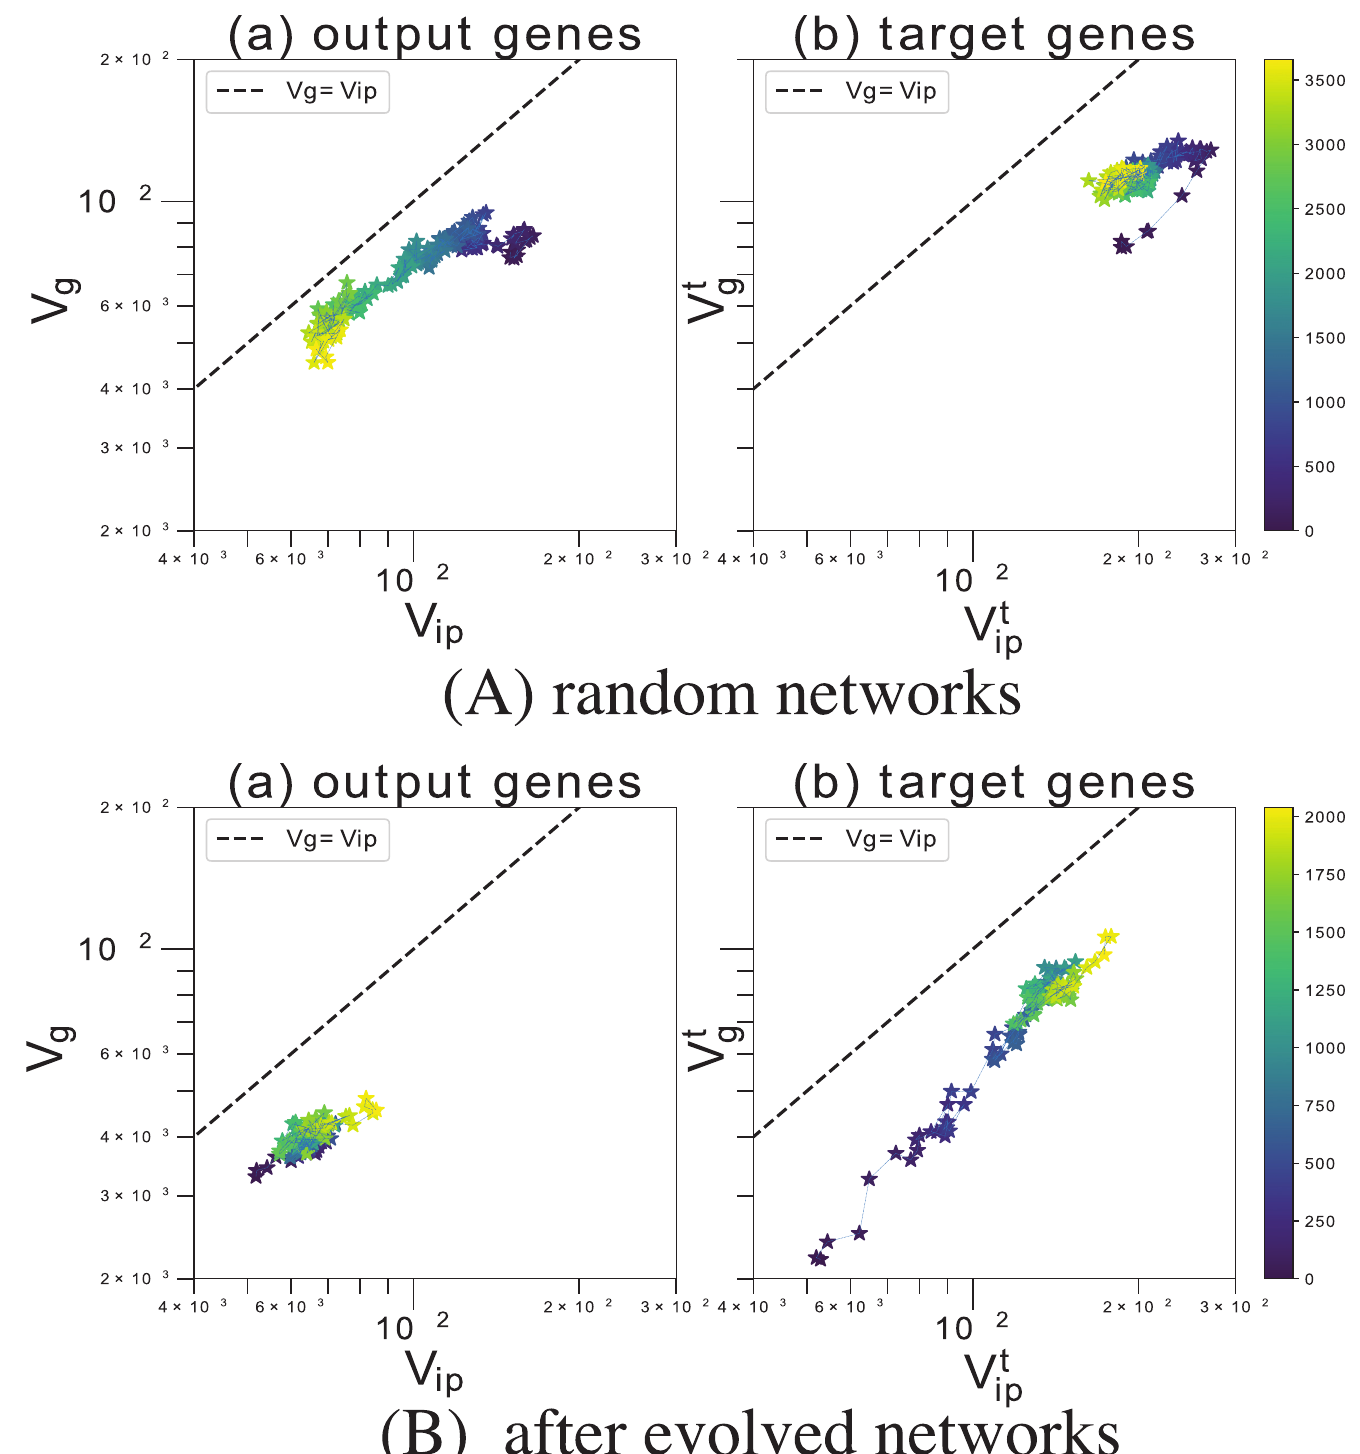
Fig 7. Time course of the variances ( V , V ) after switching interaction strength. (A) The time course of the variances ( V ip g ( V t , V t ) for target genes (b) plotted over generations for c = 3 when starting with initial random networks (circle; dotted lines). The variances are computed from the ip g isogenic variance over 100 iterations. The time course over generations is plotted for the variances of gene expression. The plots cover 3500 generations. We set the noise level to σ = 0.03 > σ c . The two variances of the non-target output genes decrease, while V g < V ip is maintained throughout the evolutionary course (a). Conversely, under